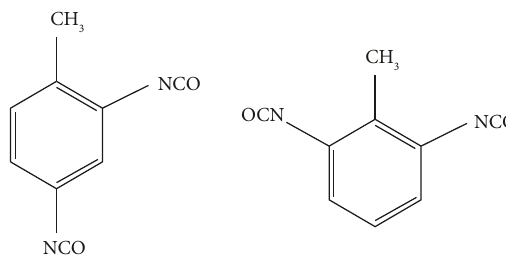
Figure 1: Chemical structure of 2,4-TDI and 2,6-TDI.